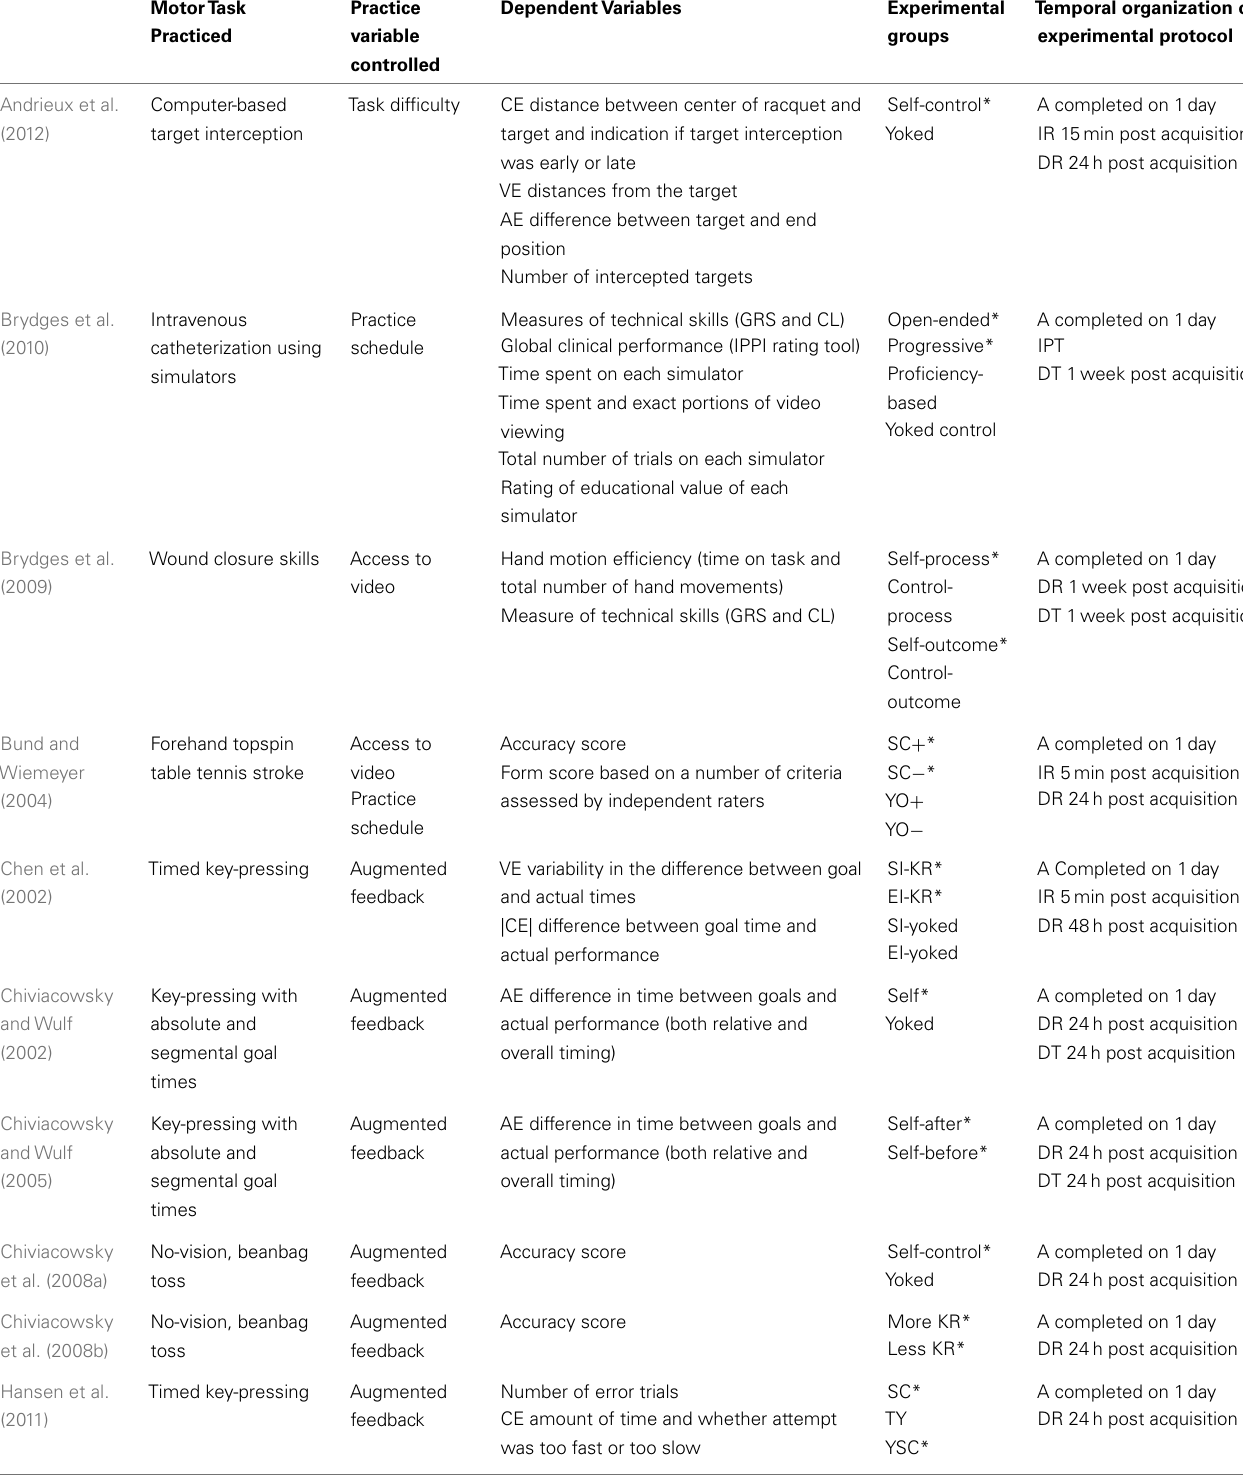
Table 1 | Elements of self-controlled practice